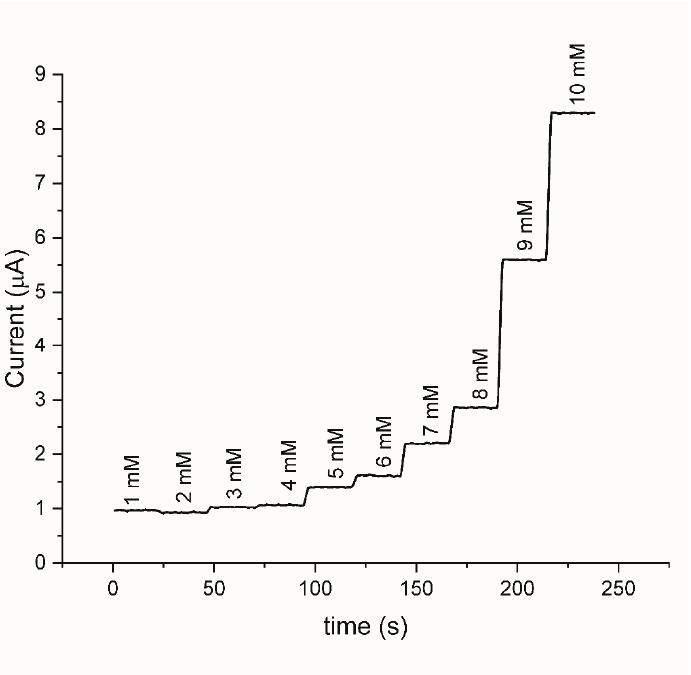
Figure 9. CV curves without a buffer (NaOH). The blue curve represents the response to 5 mM glucose. The red curve represents the response to 5 mM sucrose.